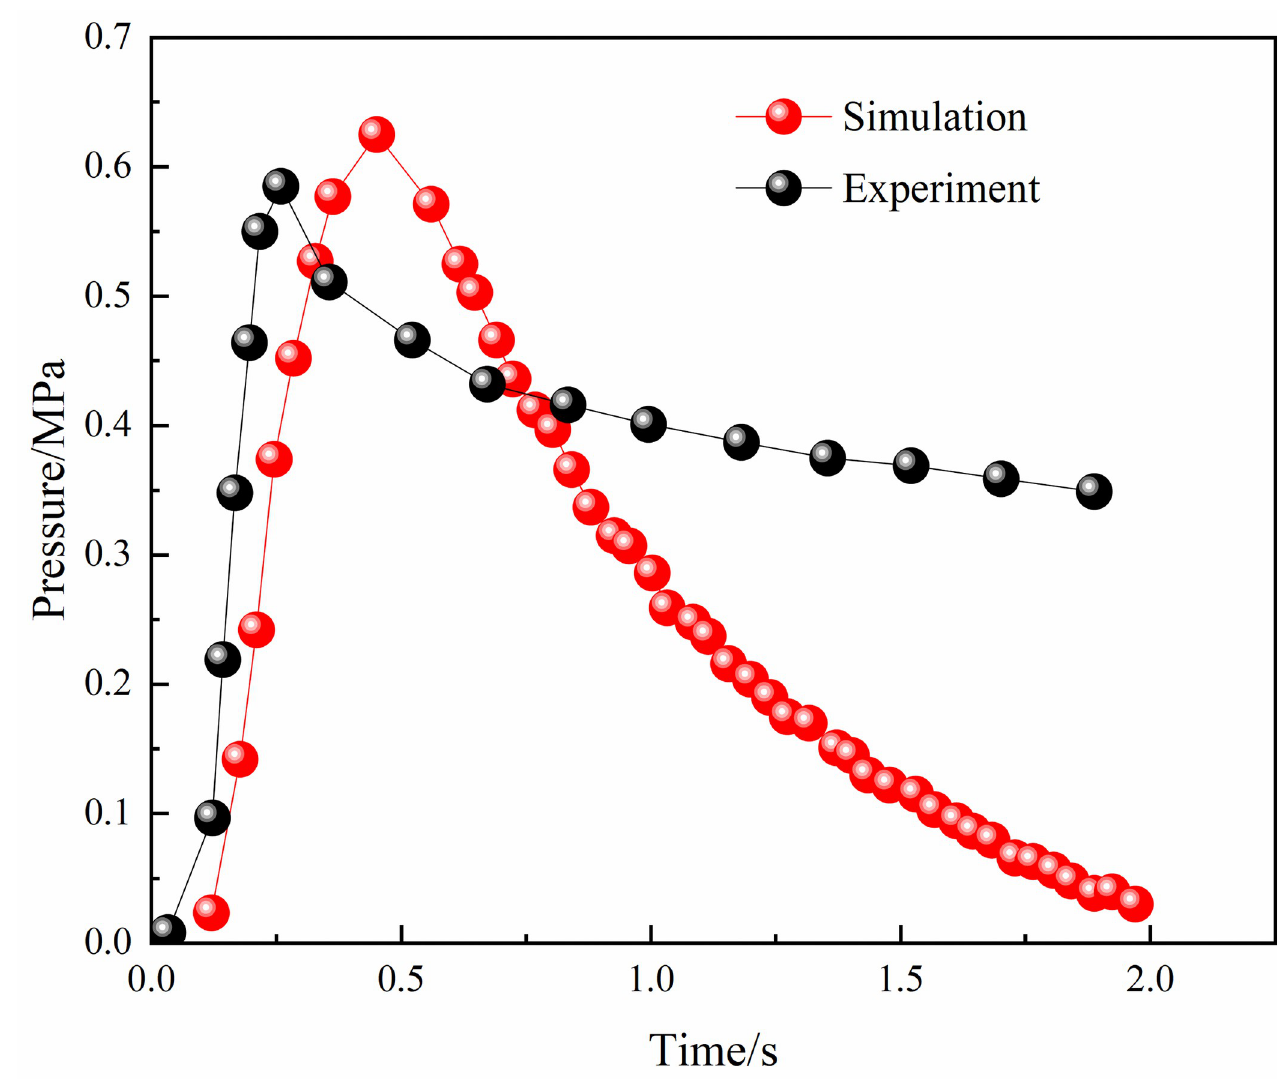
Fig 4. Experimental and simulant pressure comparison in